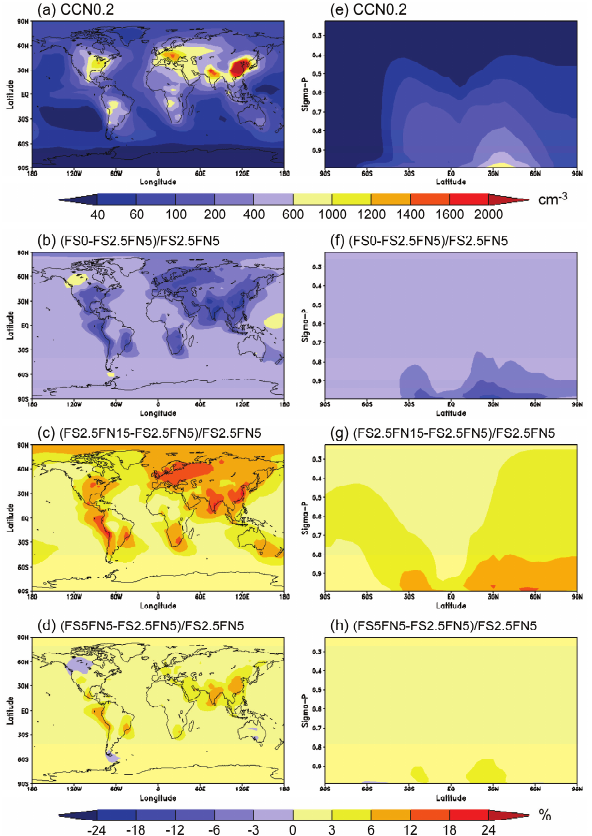
Fig. 6. Same as Fig. 1, except for the concentrations of cloud con- densation nuclei at water supersaturation ratio of 0.2%